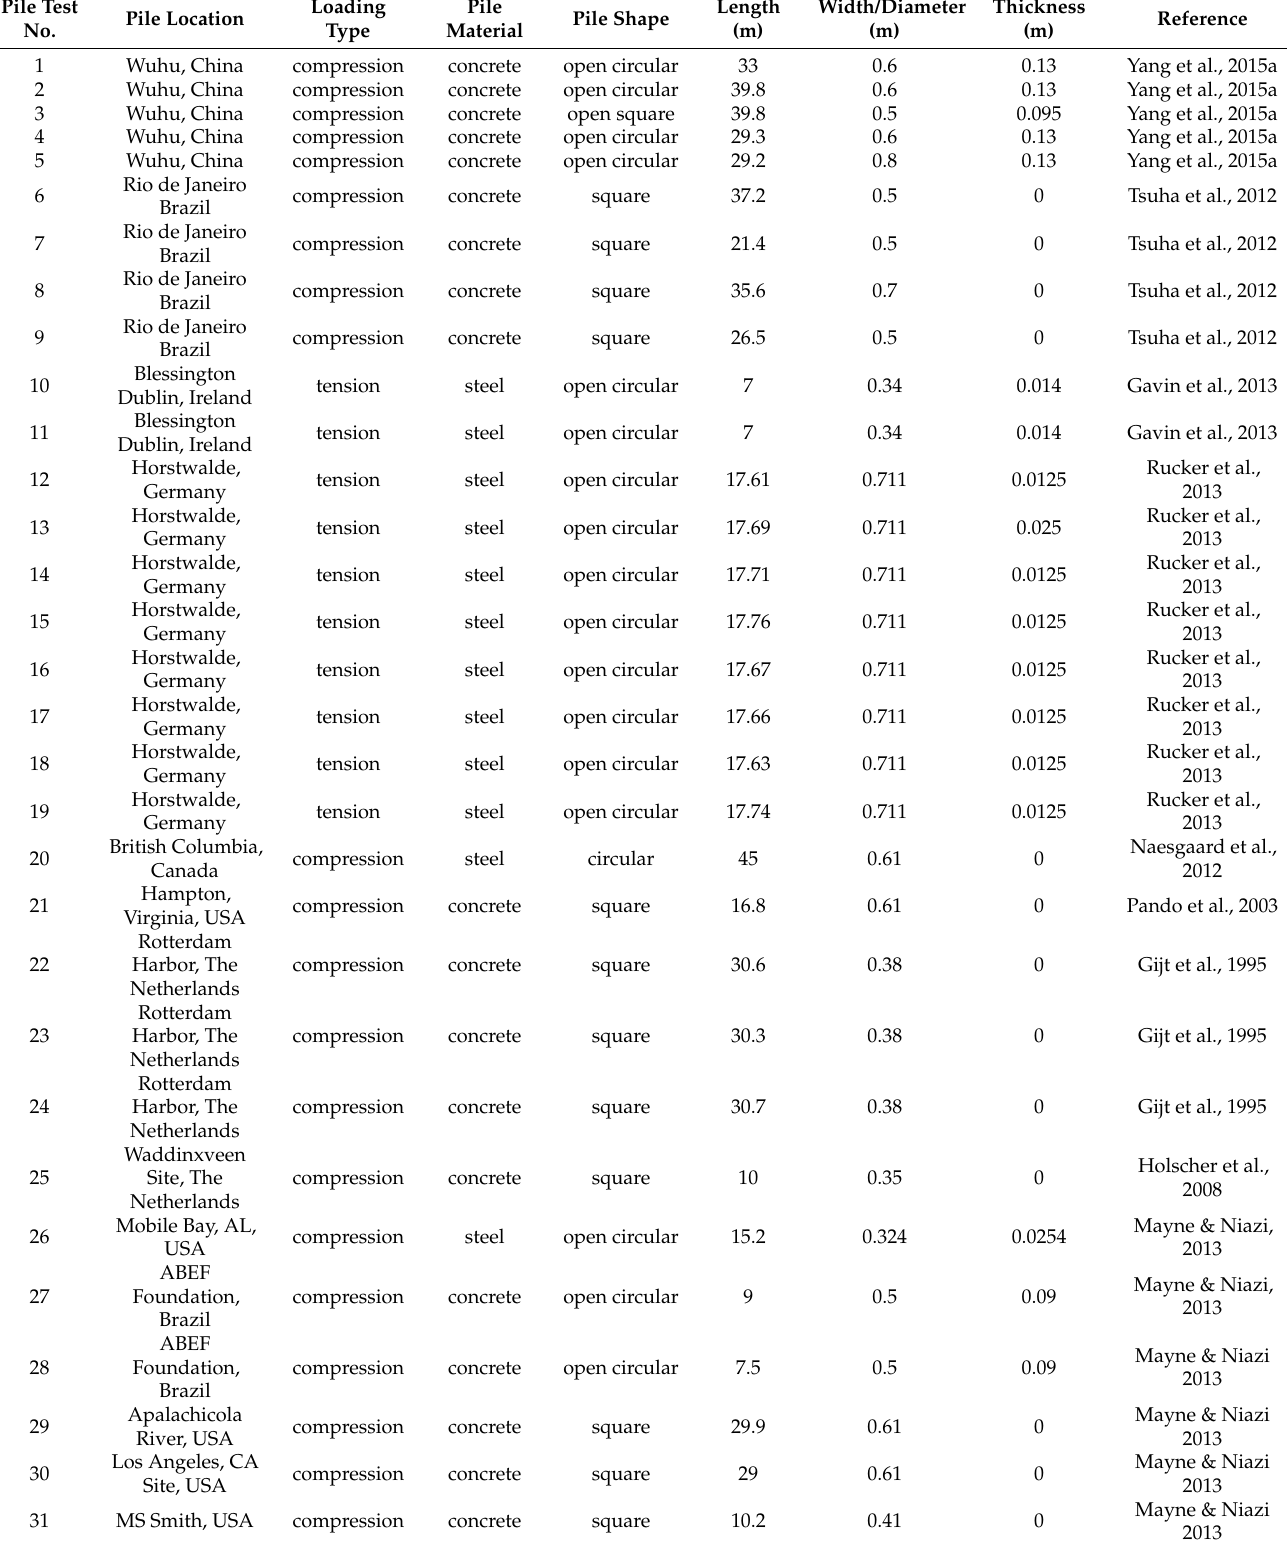
Table A1. Load test locations and pile properties of driven